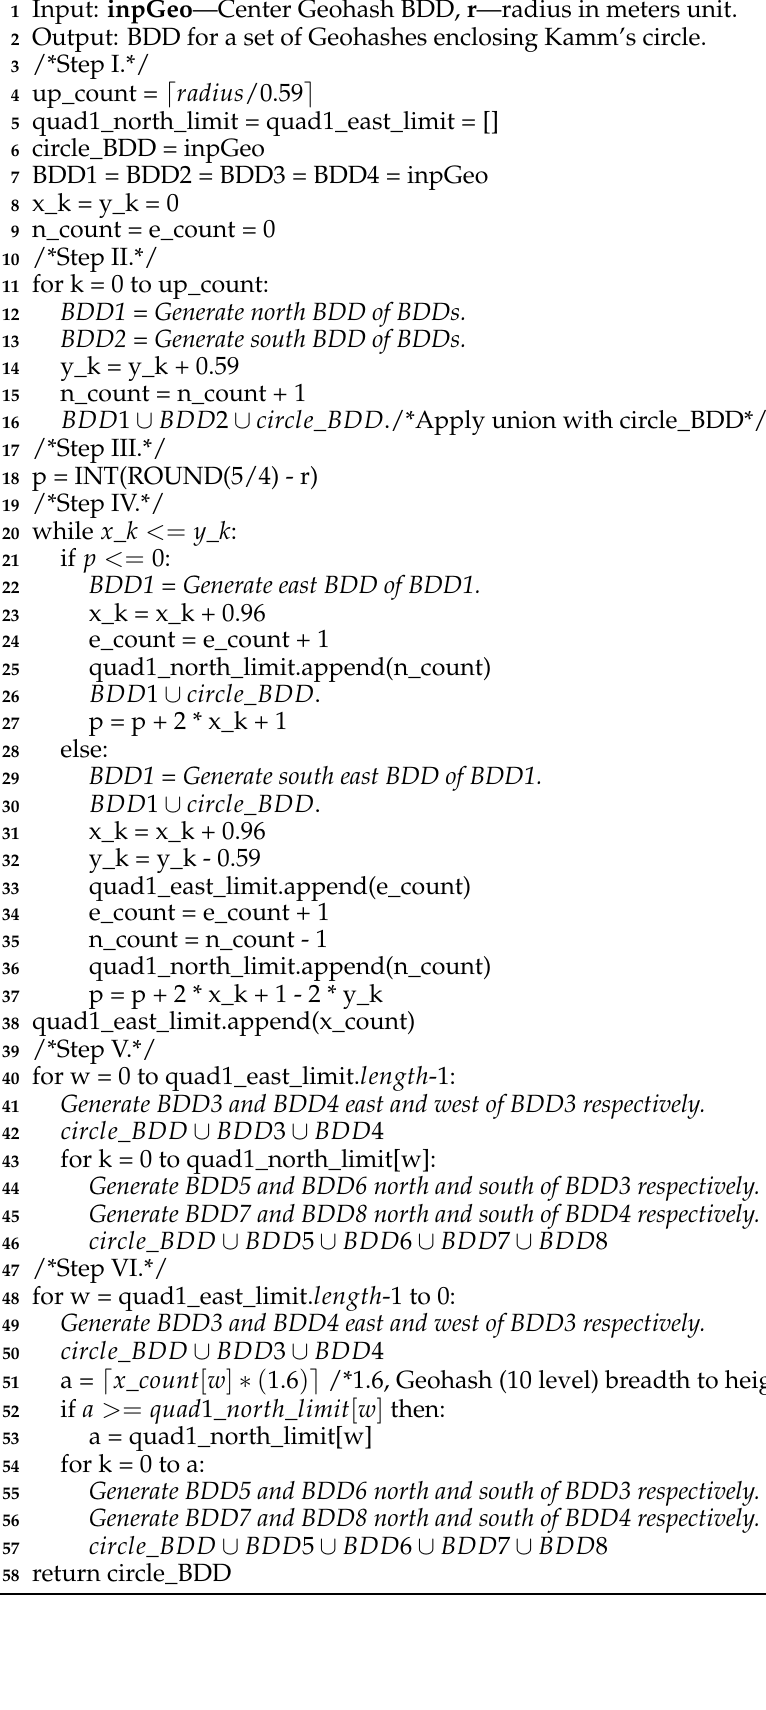
Algorithm 2: Modified midpoint circle generation